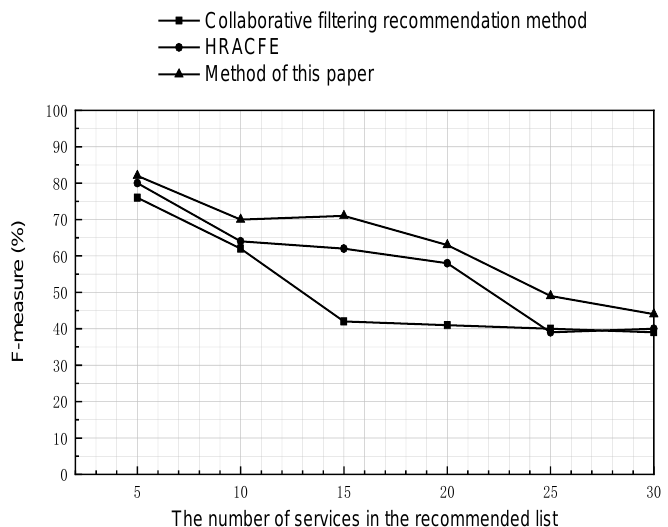
Figure 8. F-measure comparison of different recommendation methods.